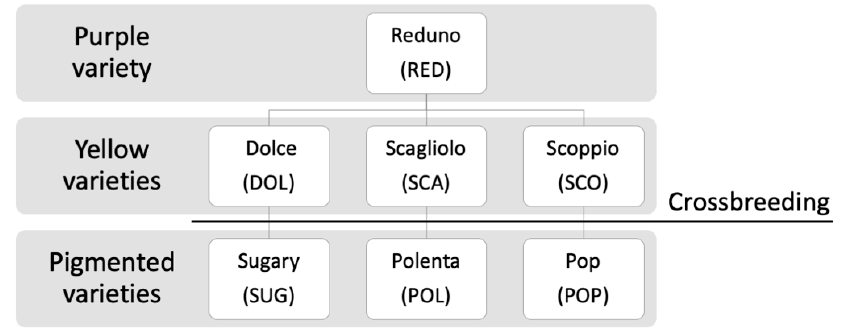
Figure 1. Corn varieties included in the study and relative